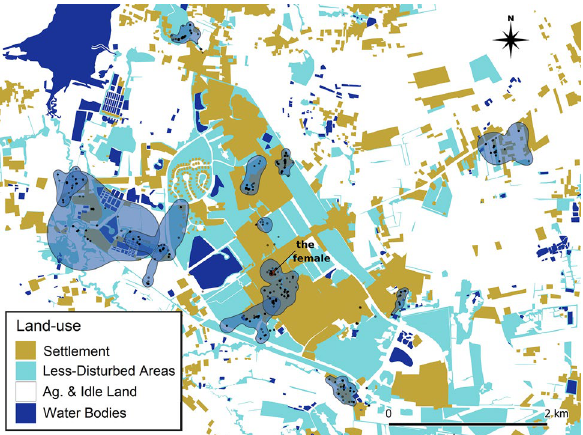
Figure 2. dBBMM occurrence distributions (male 99% confidence area polygons in blue, female 99% confidence area polygon in red) and location fixes (semi-transparent black dots) for each radio-tracked B. candidus individual in Muang Nakhon Ratchasima, Thailand. Map created using QGIS v.3.8.2 (https:// qgis. org/) in combination with Inkscape v.1.1.0 (https:// inksc ape.